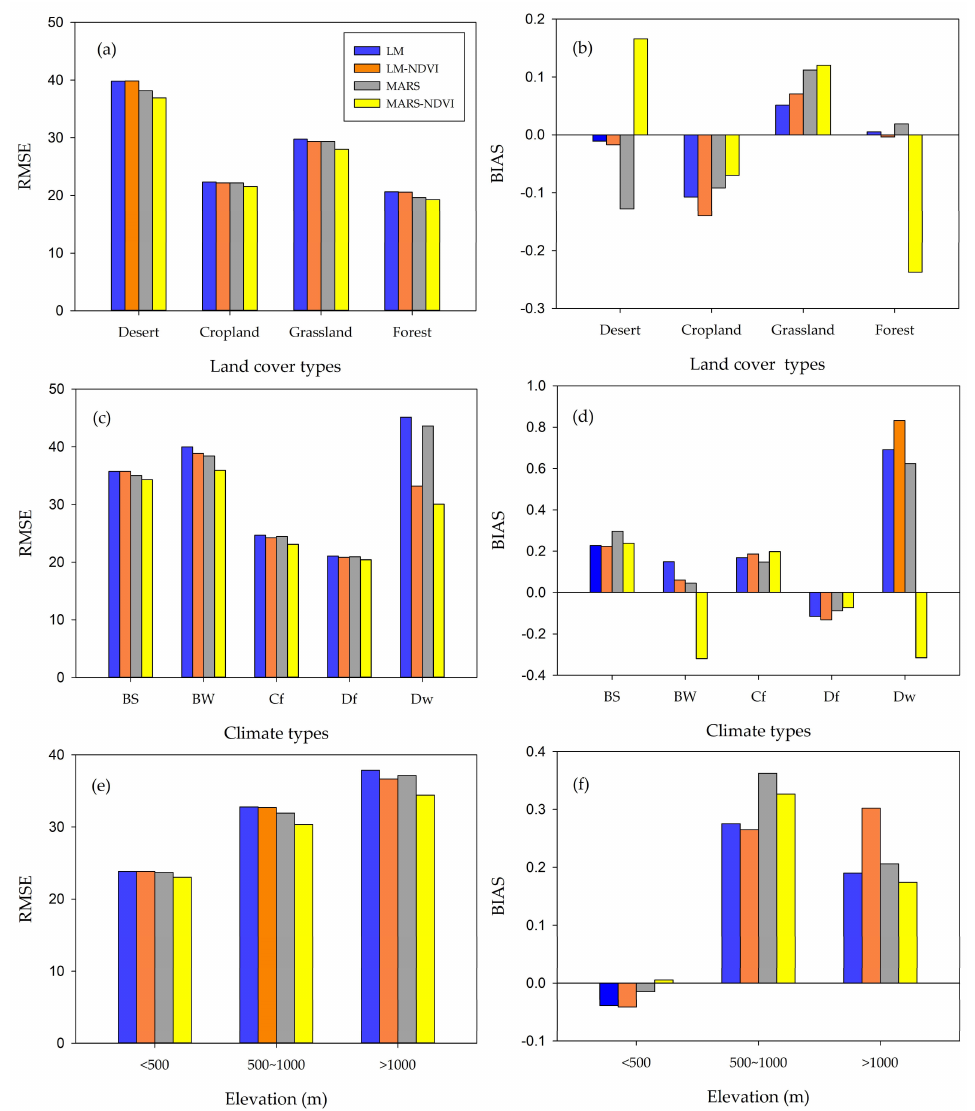
Figure 8. Evaluation results of the four models for the different land cover types ( a , b ), climate types ( c , d ), and surface elevations ( e , f